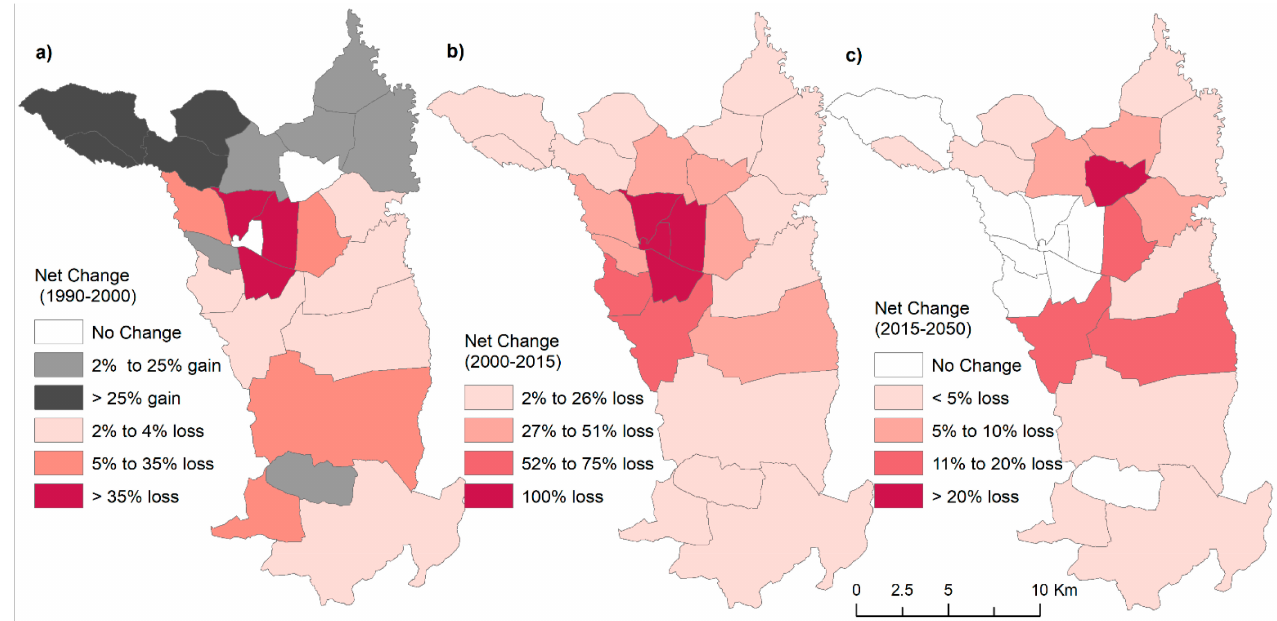
Figure 9. Net change in agricultural land in a district for the periods of 1990–2000 ( a ), 2000–2015 ( b ), and 2015–2050 ( c